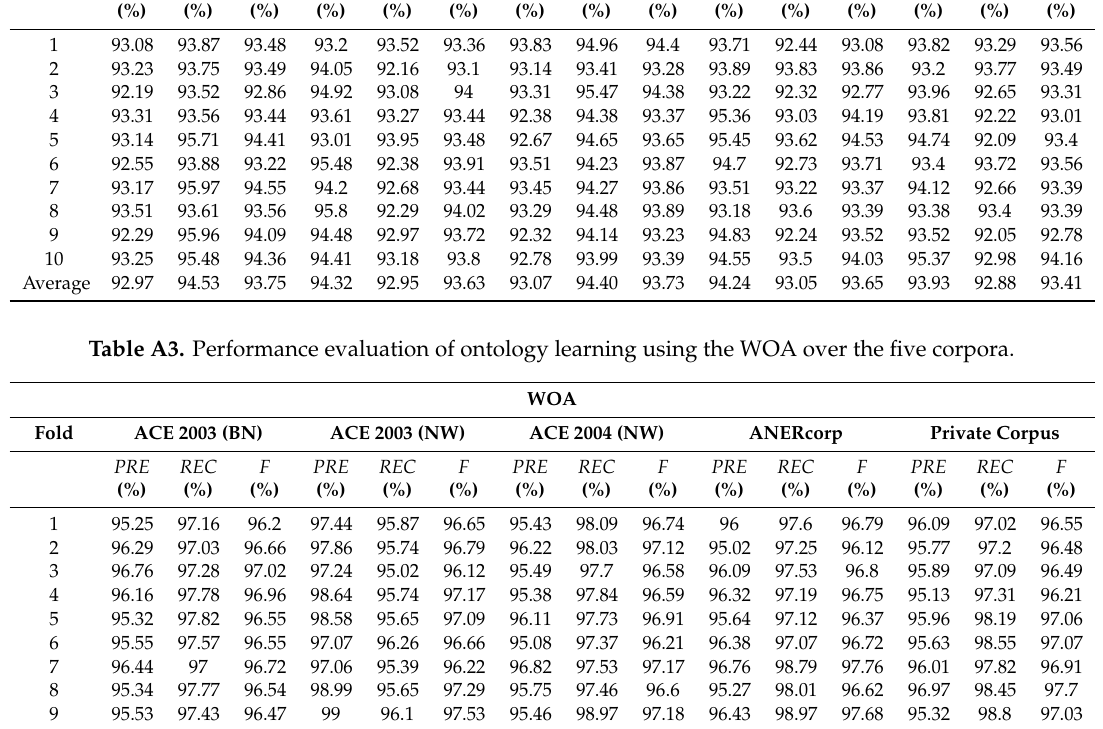
Table A4. Performance evaluation of ontology learning using the PSO over the five corpora.